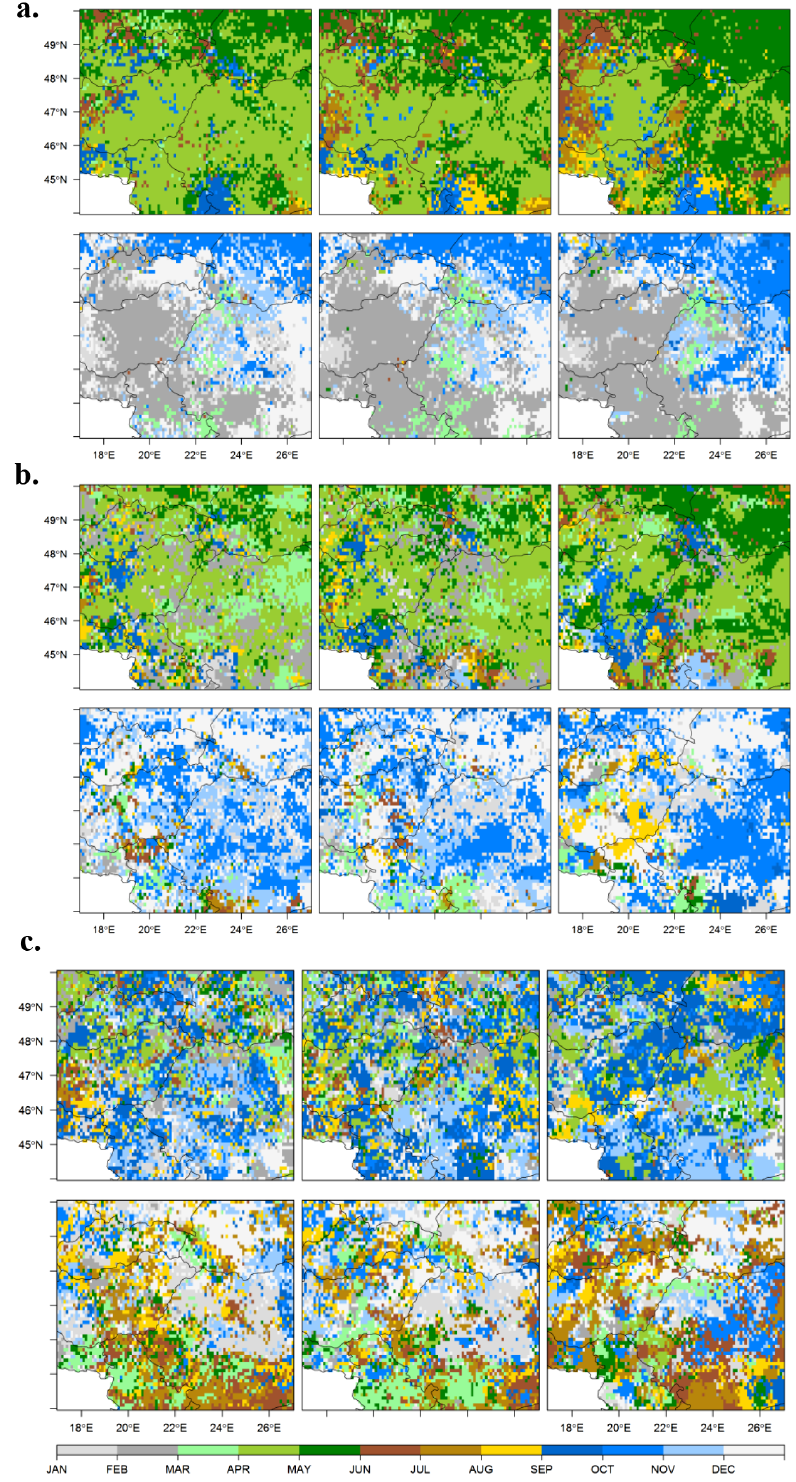
Figure 8. The months with the highest (top), and lowest (bottom) probability of having (left) a moderate drought ( − 3<Sc-PDSI ≤ − 2), (center) severe ( − 4<Sc-PDSI ≤ − 3) and (right) extreme drought ( − 4 ≤ Sc-PDSI) terminated in (a) the next month, (b) the next 3 months and (c) the next 6